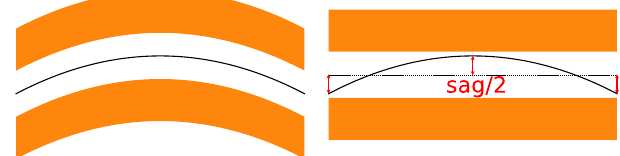
FIG. 6. Reference beam path through bent (left) and straight (right) dipoles and resulting beam sagitta